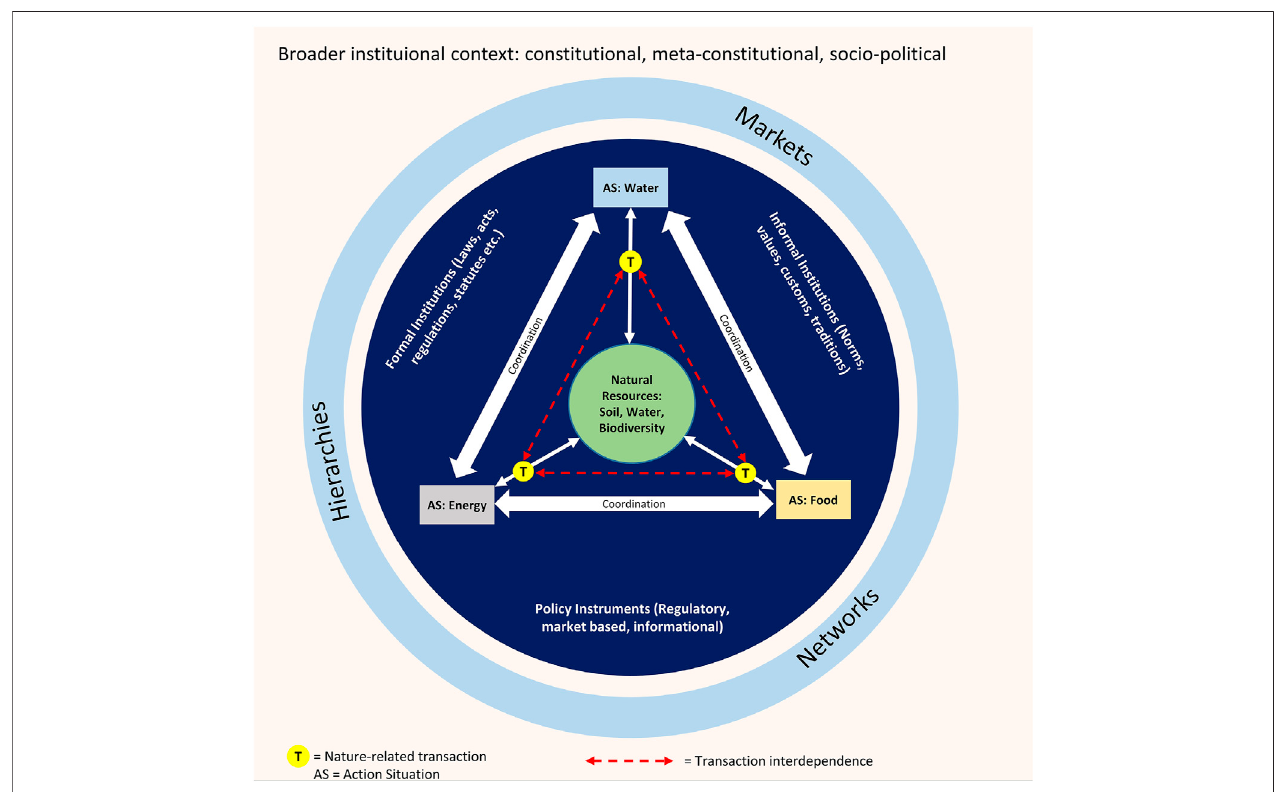
FIGURE 1 | Polycentric view of water-energy-food (WEF) nexus governance. Source: Authors.